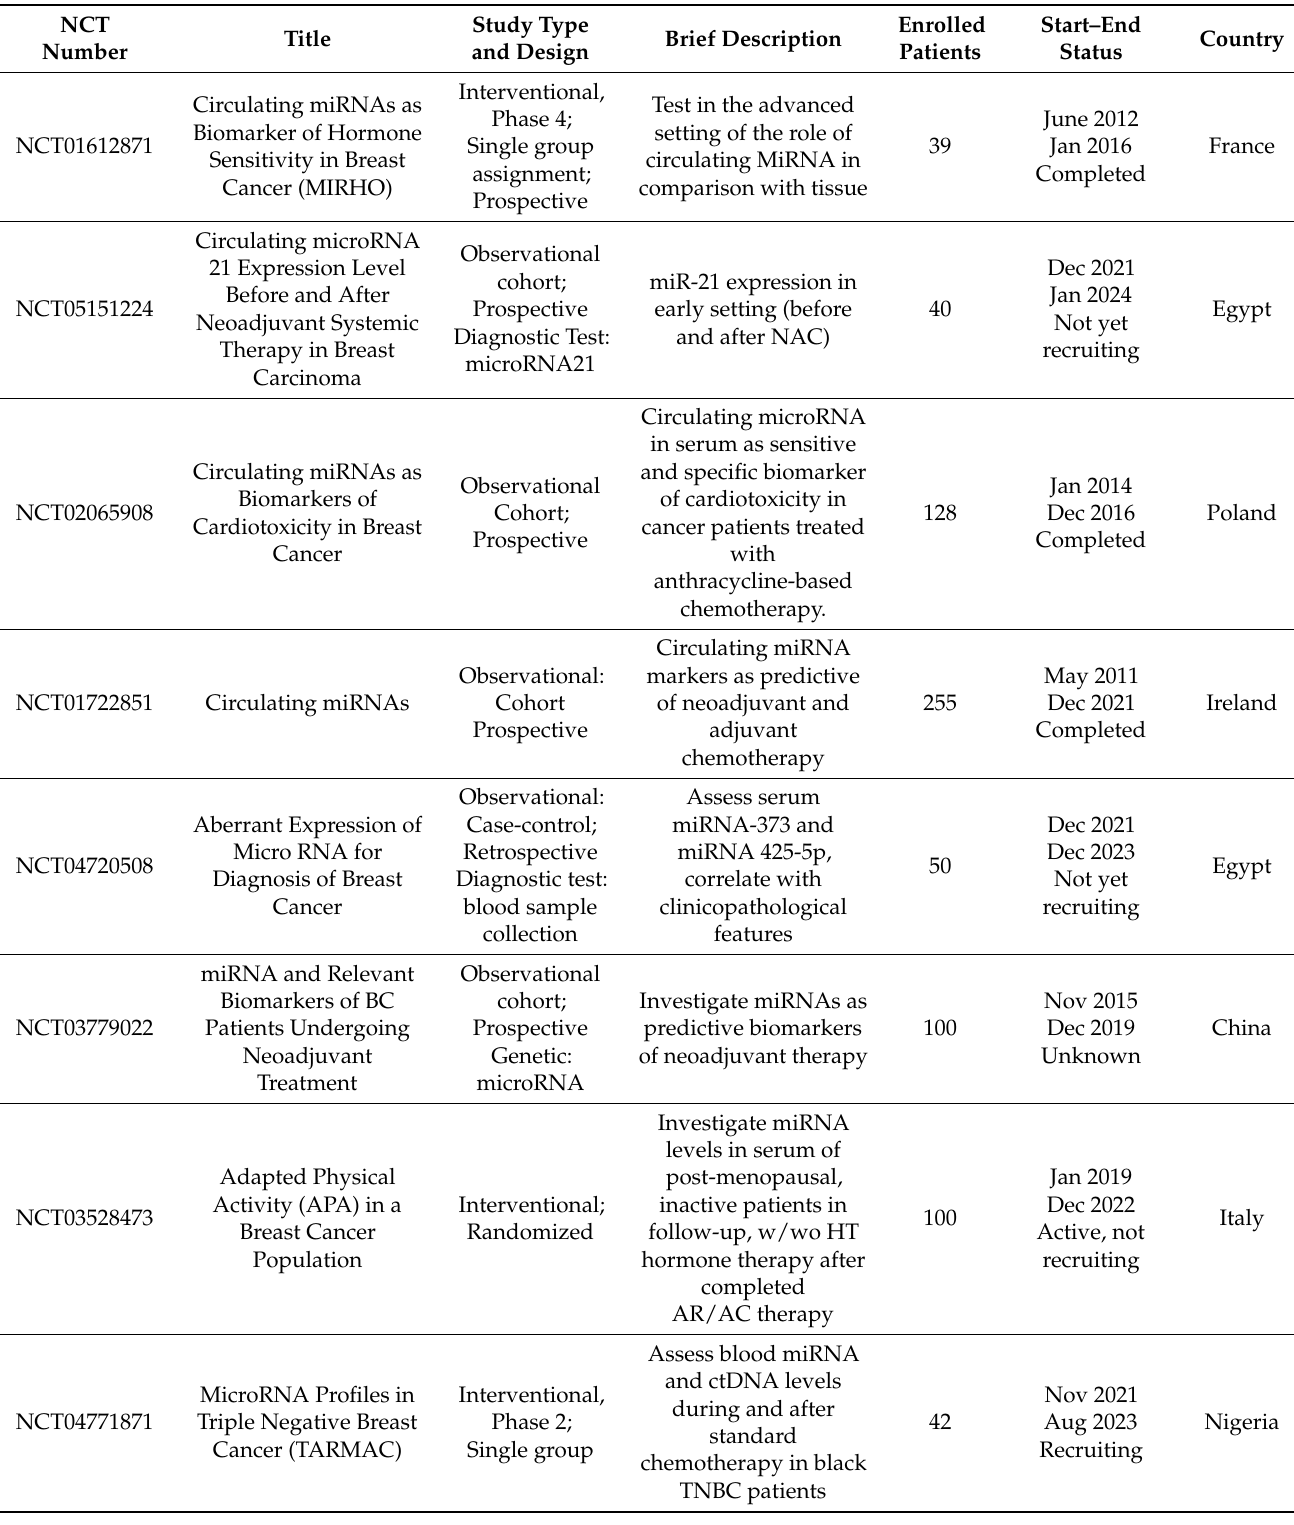
Table 3. The table illustrates clinical trials registered by 31 March 2022 (clinicaltrials.gov, searching for “miRNA” and “circulating microRNA” and “breast cancer” or “exosome” and “miRNA” and “breast